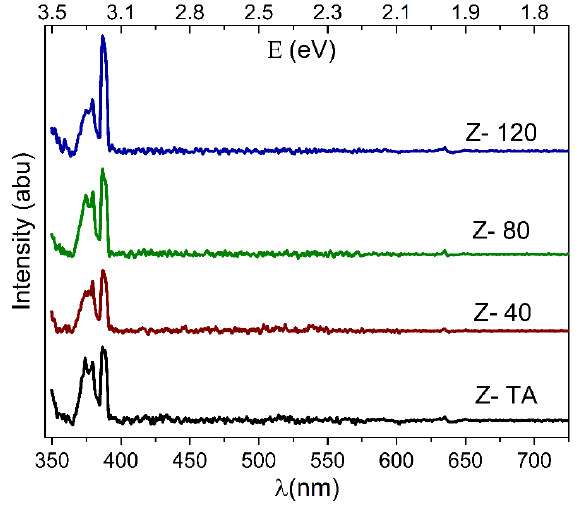
Figure 7. The PL spectra obtained for thermally treated and UV-A treated ZrO 2 films indicate good quality films due to pronounced UV emissions in comparison to visible emissions. Table 2. Peaks positions and their FWHM obtained from PL spectra for thermally treated and UV-A treated ZrO 2 films.